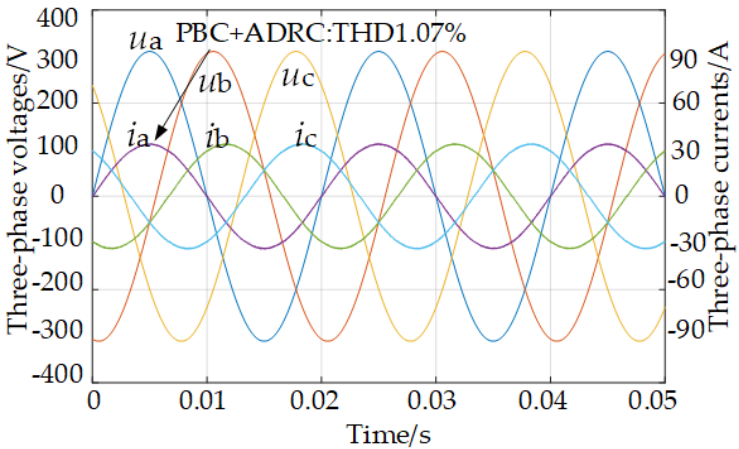
Figure 5. Three − phase unbalanced (phase shift) grid voltages and three − phase input currents.